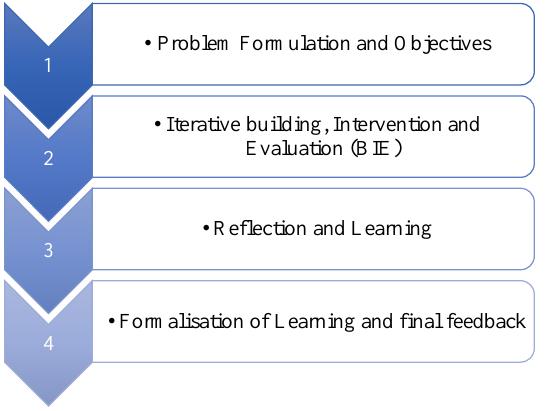
Figure 2. Action Design Research process